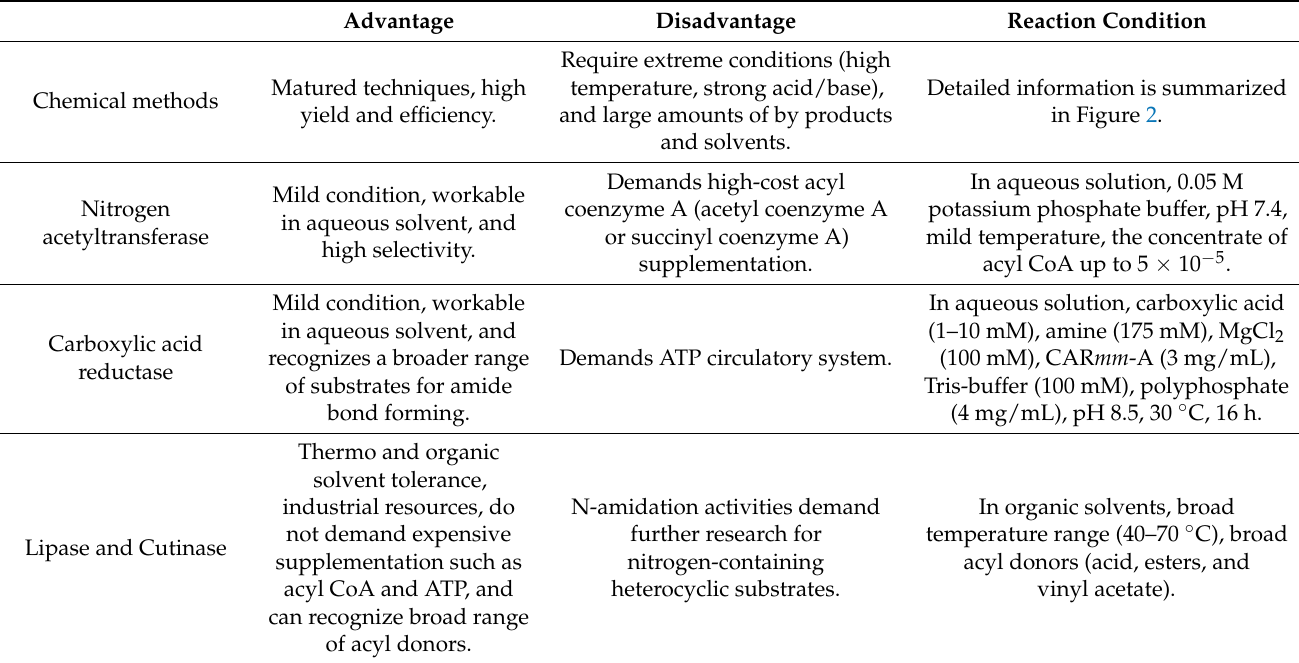
Table 2. Comparison of chemical and enzymatic methods in amides forming of N-heterocyclic